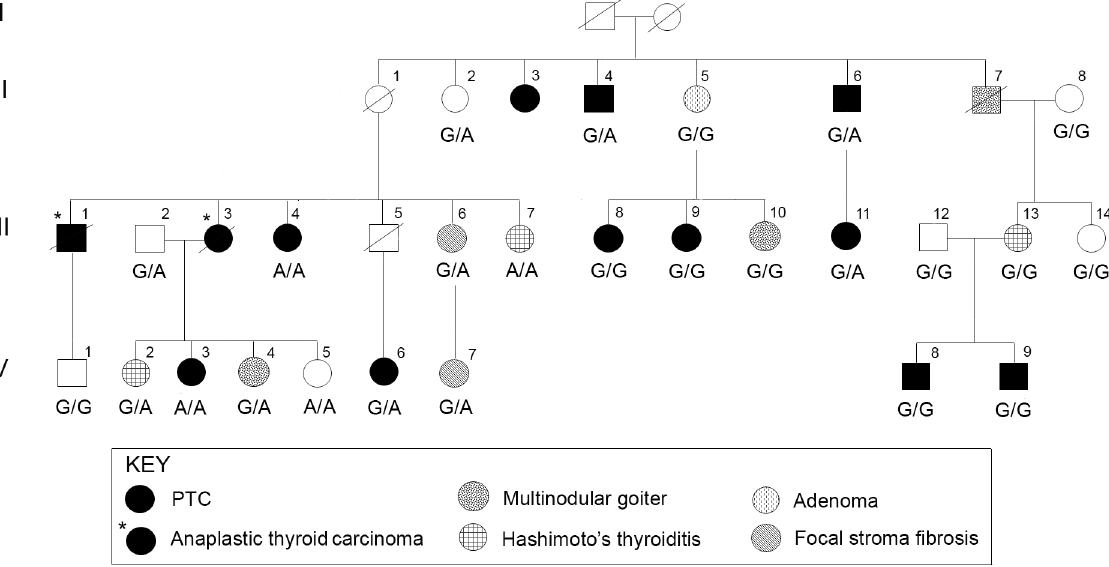
Fig 1. Genotyping of HABP2 G534E variant in Family 1. The pedigree shows genotypes of the HABP2 variant (c.1601G > A; p.G534E). Circle, female; square, male. Please note that in this family the basis of the predisposition to PTC has been determined. It is a single nucleotide variant in a long-range enhancer on chromosome 4q (He et al., 2013)